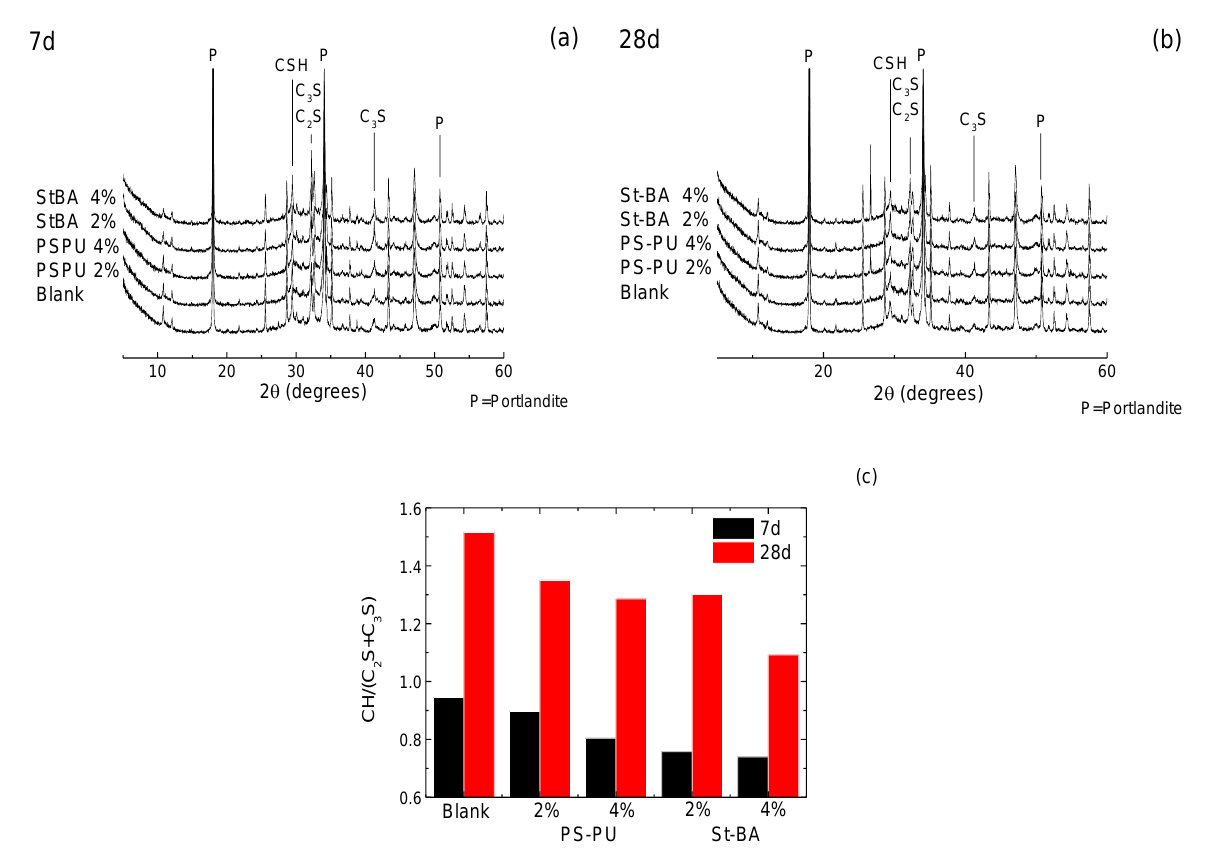
Figure 6. XRD characterizations of the latex-modified mortars: ( a ) XRD spectra at 7 d; ( b ) XRD spectra at 28 d; ( c ) CH/(C 2 S+C 3 S) data based on Rietveld calculation on XRD spectra; peak identification was based on [39,40].